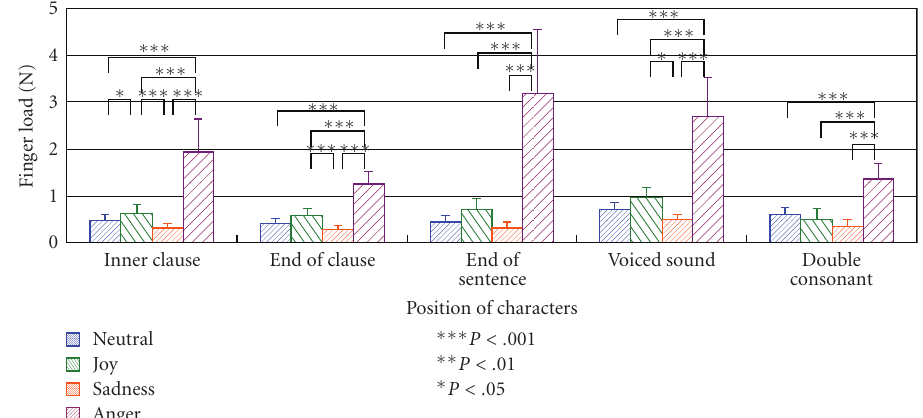
Figure 7: Mean of finger load as a function of emotions and position of characters for two-handed Finger Braille (error bars represent standard deviations).